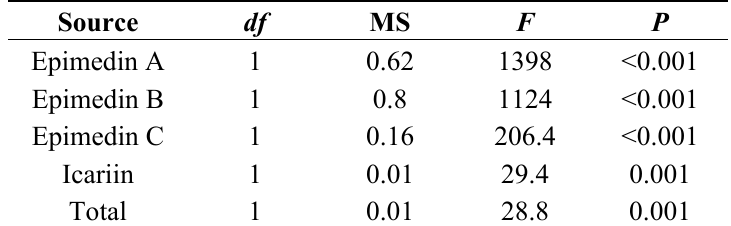
Table 2. ANOVA analysis of flavonoid contents under two light intensities (60–160 μ mol/m 2 /s, plot 1; 200–650 μ mol/m 2 /s, plot 2) in Wuhan Botanical Garden.